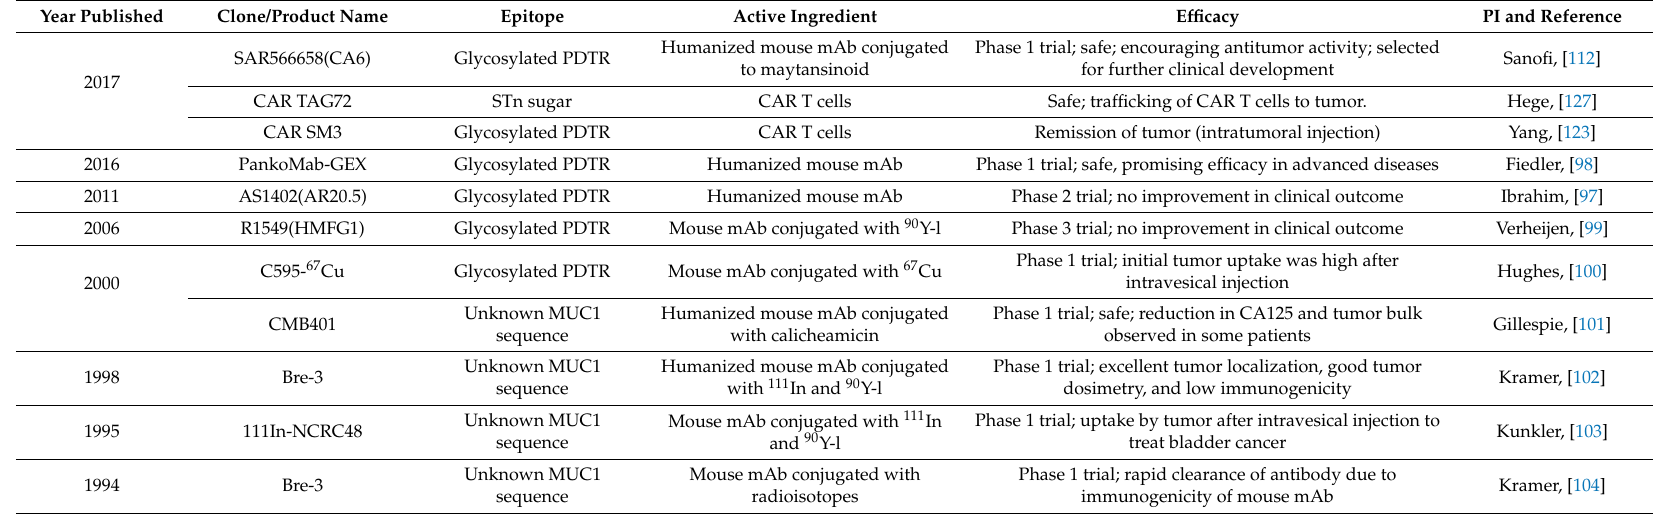
Table 2. Clinical trials of MUC1-specific monoclonal